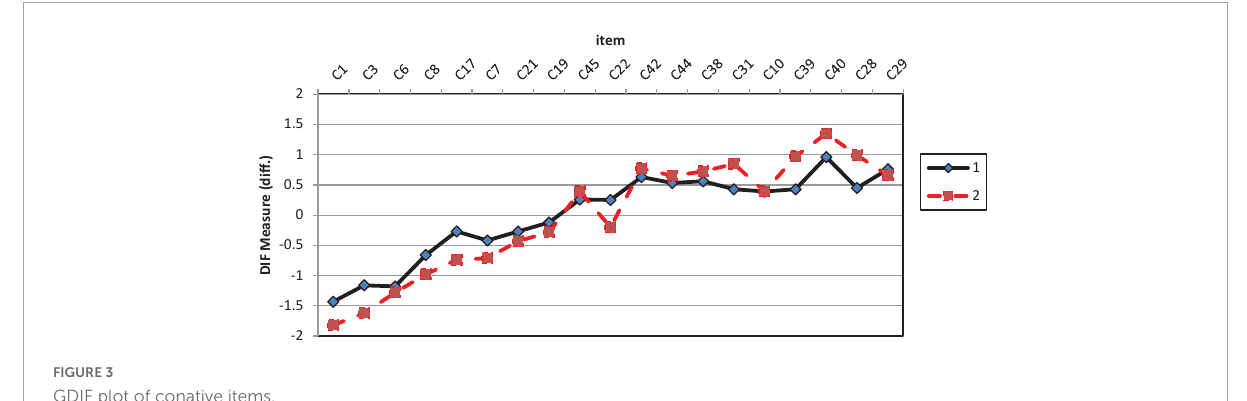
FIGURE3 GDIF plot of conative